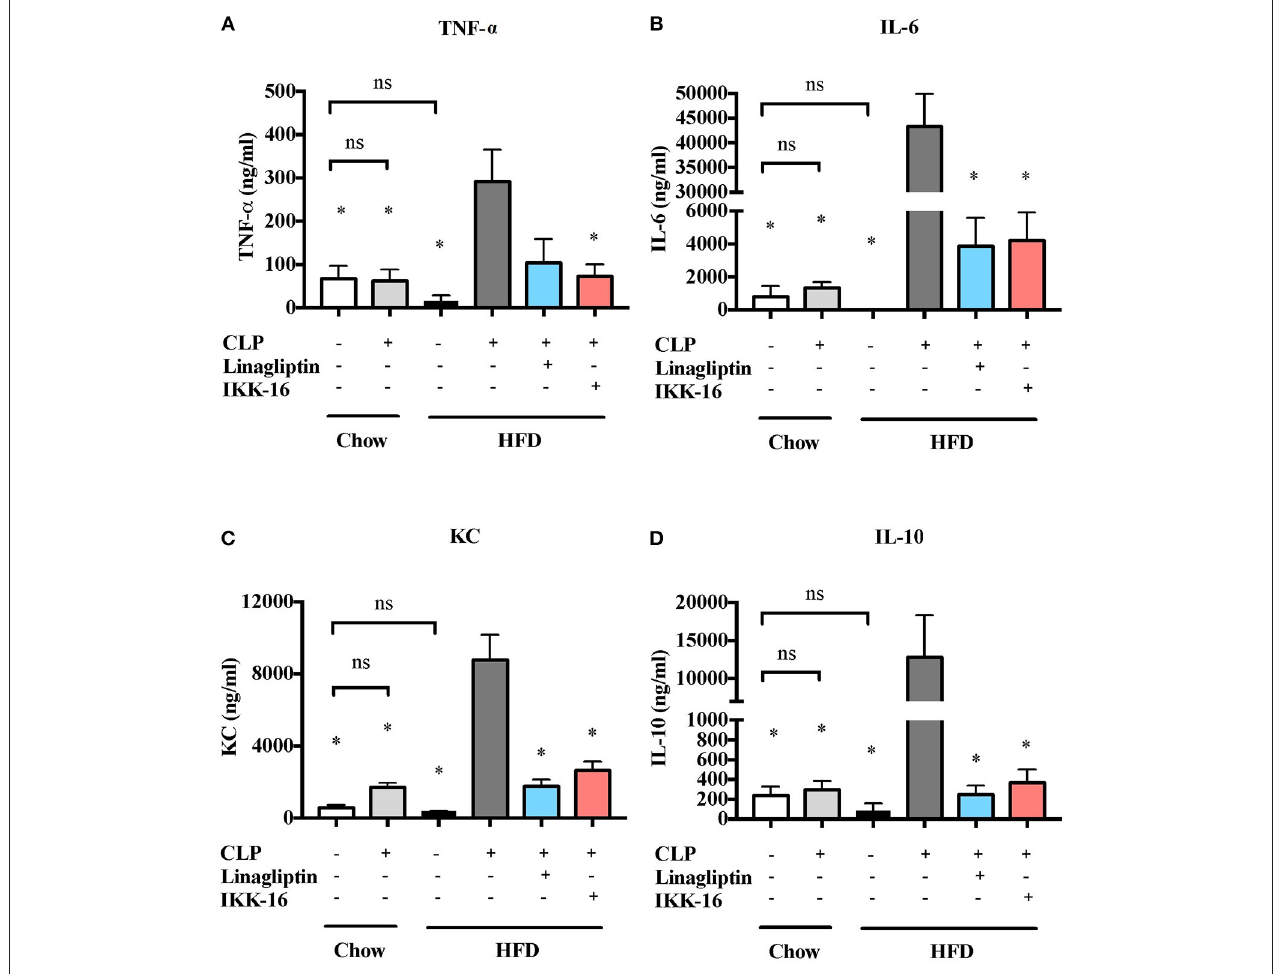
FIGURE 4 | Effects of CLP challenge and linagliptin or IKK-16 post treatment on systemic inflammation in mice with T2DM . Mice from chow and HFD groups were randomized to undergo CLP or sham surgery. At 1h after CLP, mice on HFD were randomized to receive linagliptin (10 mg/kg, i.v.), IKK-16 (1 mg/kg, i.v.), or vehicle (2% DMSO, 3 ml/kg). At 24h after CLP, blood samples were collected and inflammatory cytokines concentrations were measured in the serum. (A) TNF- α , (B) IL-6, (C) KC, and (D) IL-10. Data was analyzed using one-way ANOVA followed by Bonferroni’s post-hoc test and expressed as mean ± SEM. * P < 0.05 compared to HFD + CLP group. ( n = 4 per sham surgery group and n = 6–8 per CLP